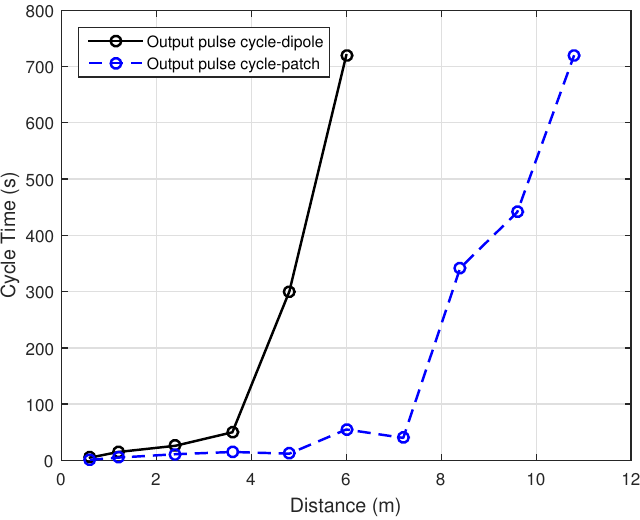
Figure 8. Charging time vs distance.